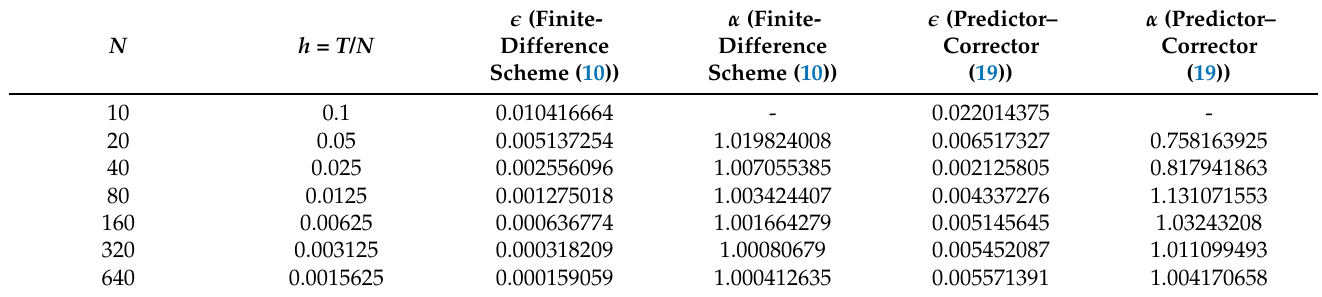
Figure 3. A test example. Solutions of the Cauchy problem (7) obtained by schemes (10), (19) and (21), as well as the exact solution (24) Table 3. Error and computational accuracy of the numerical scheme (10) and “predictor– corrector”